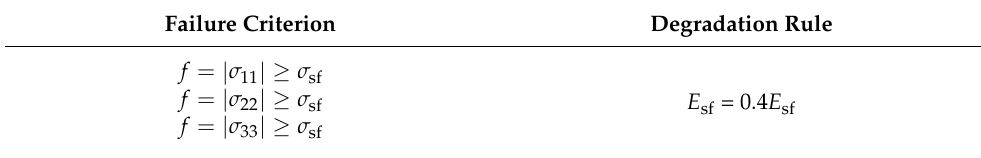
Table 5. Failure criteria and degradation rules for the short fiber composite